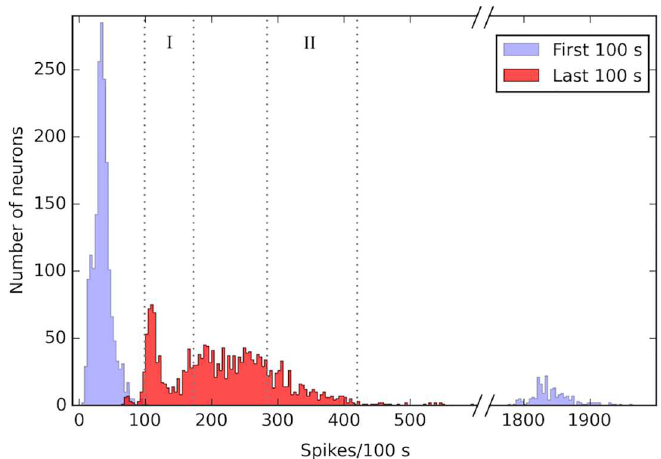
Fig 8. Firing rate distribution. This figure shows the cumulativenumberof neuronsin each firing rate bin for 20 networks. Before learning(first 100 s, blue), most neuronshave a very low firing rate (leftmost peak) except for the input neurons(rightmost peak). After learning(last 100 s, red), the neuronsare distributed in 2 groups: low firing rate (2nd peak from the left) and medium firing rate. 50% of the Output Zone B neuronsare containedin the zone marked I; 50% of the Output Zone A neuronsare containedin the zone marked